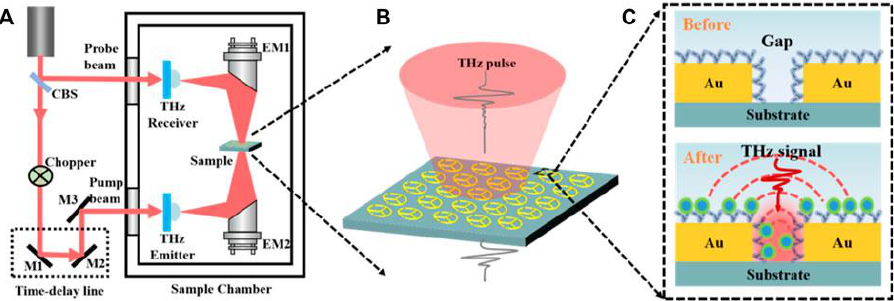
Figure 10. Graphical illustration of the experimental setup and the sample adopted by Niu and co-authors: ( a ) THz-TDS setup, ( b ) magnified picture of the sensor, and ( c ) schematic representation of Au structures and air gaps before and after the combination of the S1 protein. Reprinted from [126].